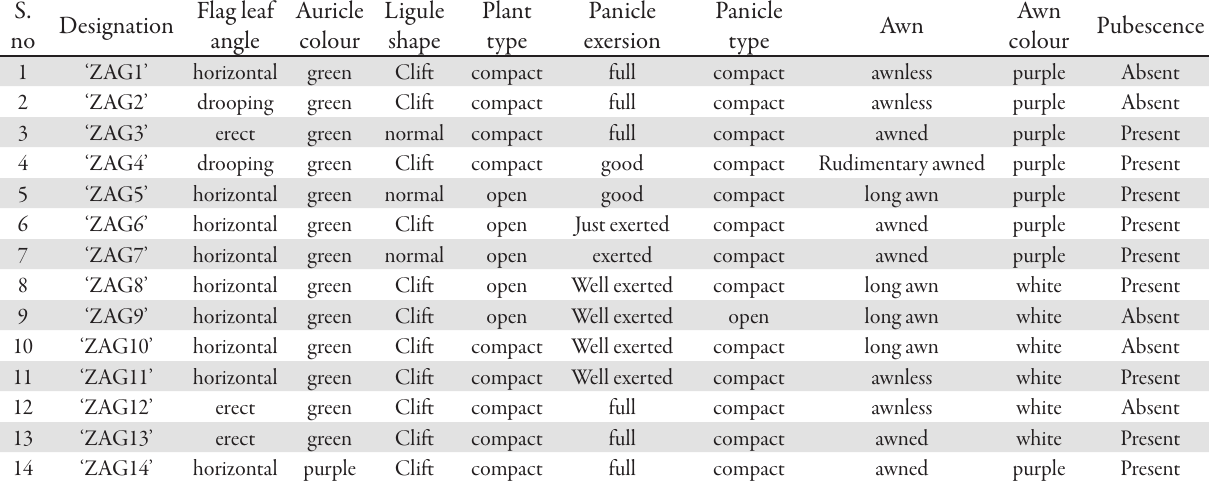
Tab. 2. Morphological characters studied for 14 red rice ecotypes from temperate region of Kashmir, India